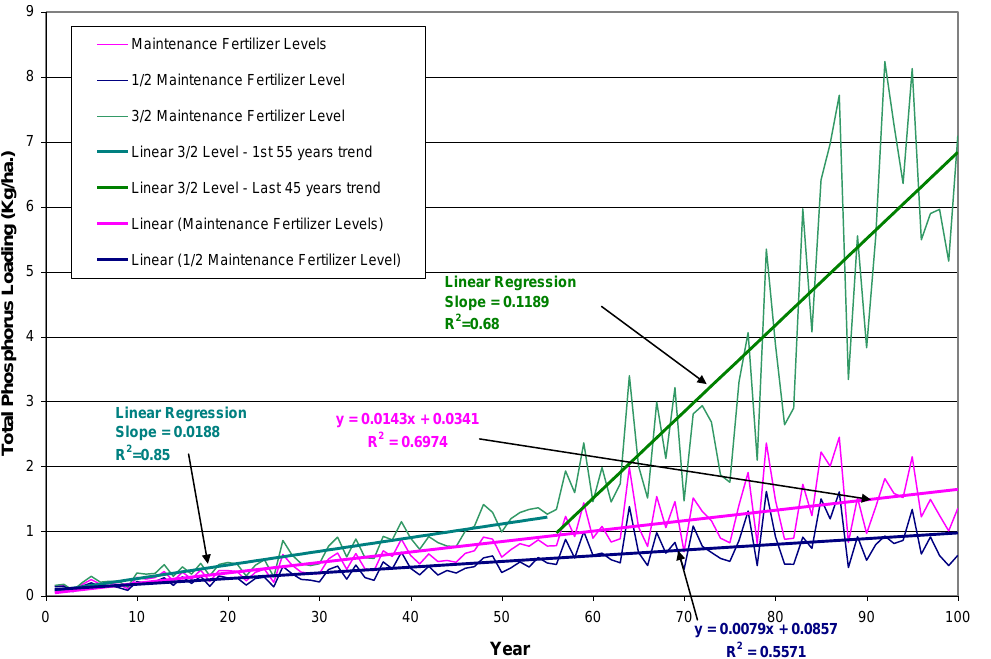
Figure 3. Annual phosphorus loading at the Upper Auglaize Watershed Outlet from different P application rates.